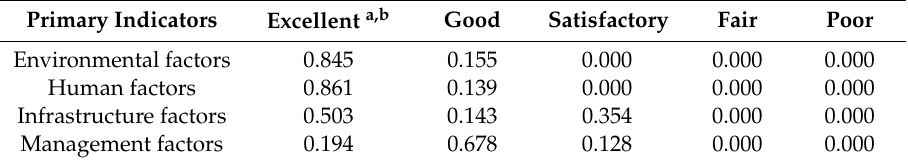
Table 7. Results of Mass function of First-level